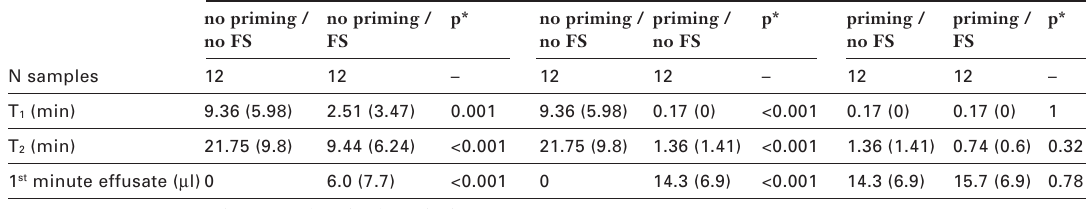
Time from starting infusion pump to first fluid delivery (T 1 ), time of first achievement of pre-set flow (T 2 ), and first-minute ef- fusate during different start-up procedures at an infusion rate of 1 ml.h –1 using an IVAC 50-ml infusion syringe. Results are shown as mean (SD).